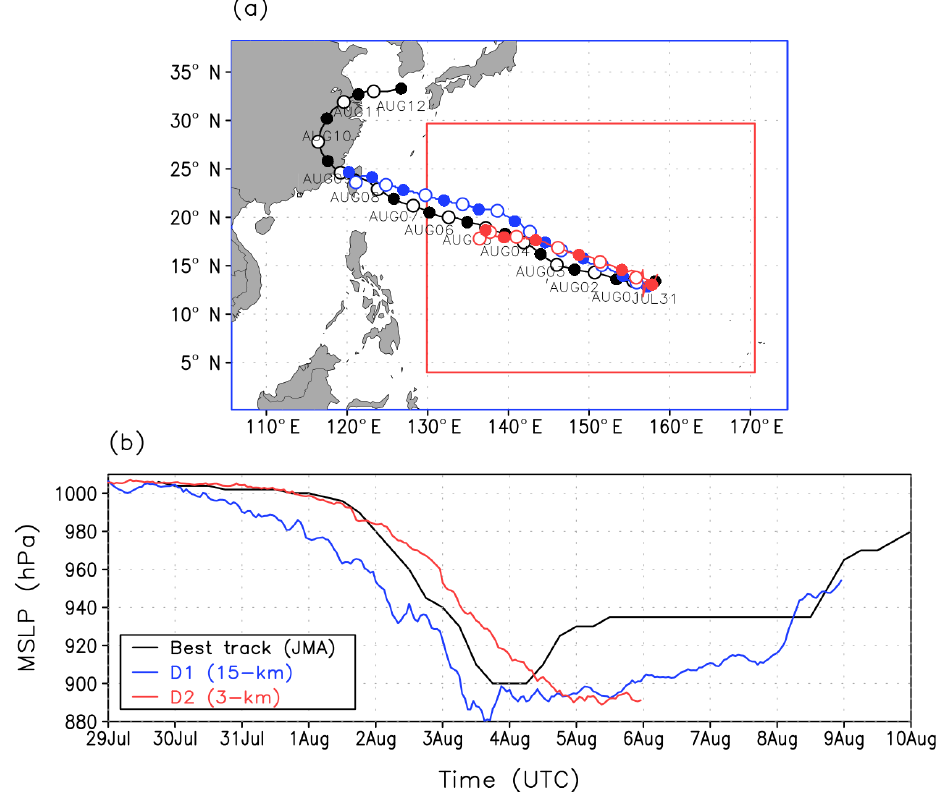
Figure 7. (a) Model domains for D1 (blue) and D2 (red) and typhoon tracks and (b) time series of minimum sea level pressure (MSLP). Black, blue, and red colors show the JMA best track data, D1 simulation, and D2 simulation, respectively. Closed and open circles in (a) denote the typhoon positions at 00:00UTC and 12:00UTC,